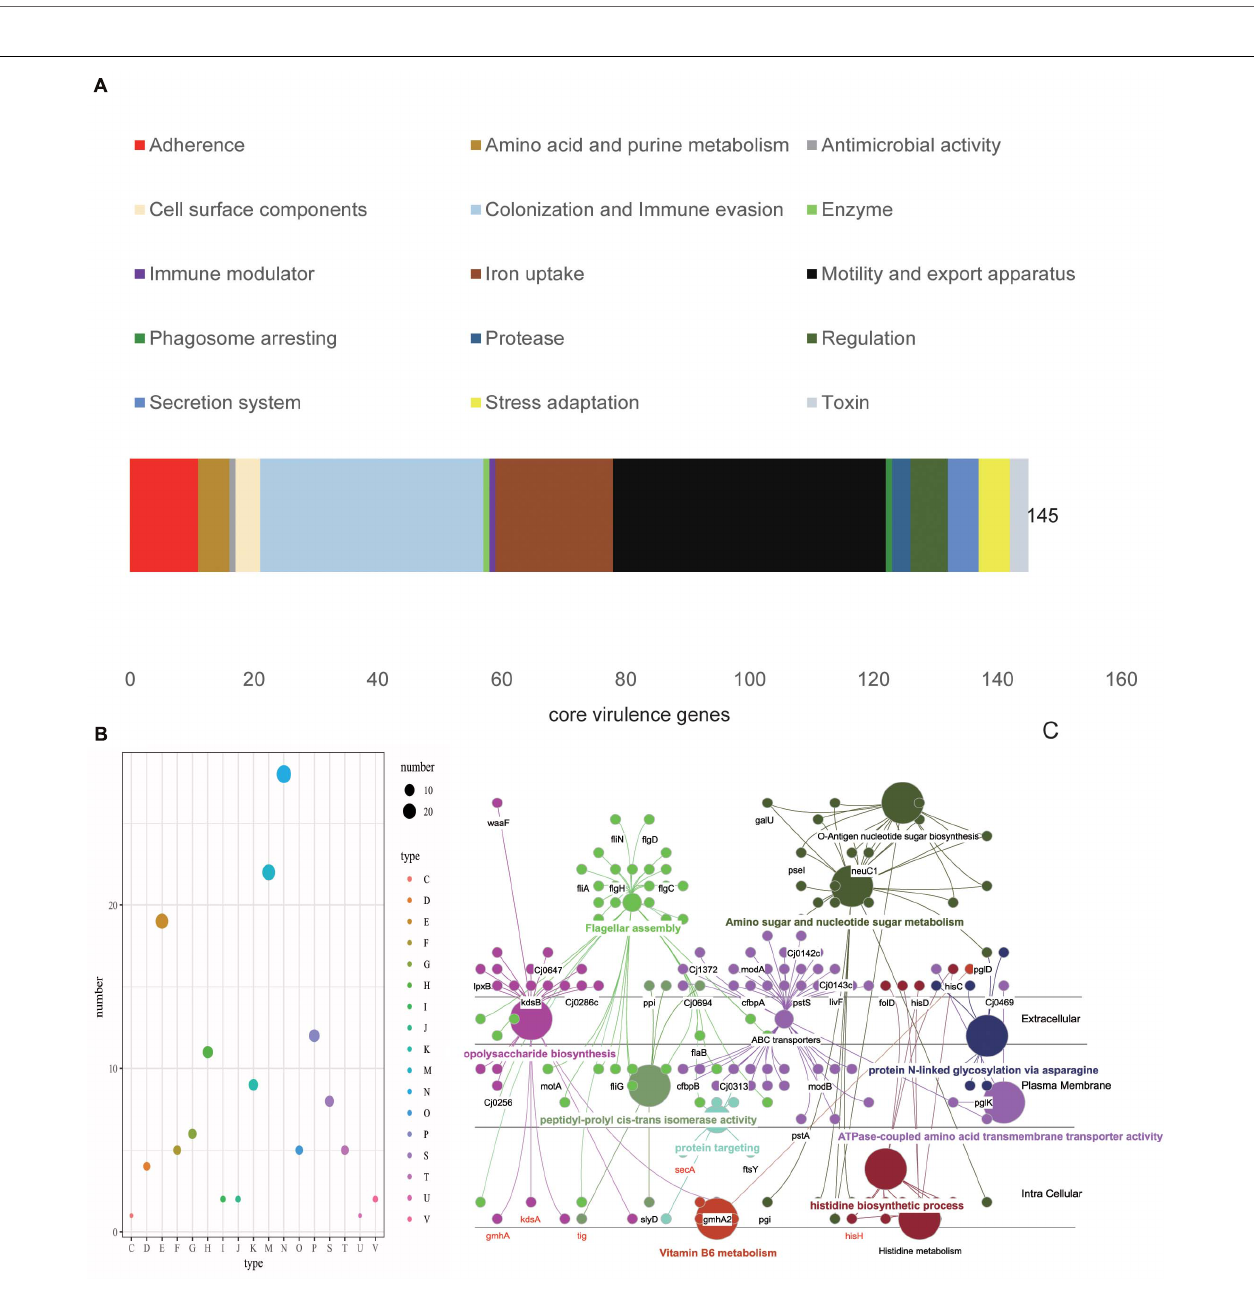
FIGURE 3 | Characterization of the core virulence factors (VFs). (A) Distributions of the virulence type categories of 145 VF proteins. The top three types are motility and export apparatus ( black ), colonization and immune evasion ( light blue ), and iron uptake ( brown ). (B) Distributions of the Clusters of Orthologous Genes (COG) types of core VFs, with the largest COGs mainly distributed in cell motility ( N ) and cell component (wall, membrane, and envelop) biogenesis ( M ), which accounted for more than 35% of the 145 core VFs. (C) Simulated location distributions of some core VFs based on Gene Ontology (GO) functional analysis that are mainly involved in motility, biosynthesis, metabolism, and